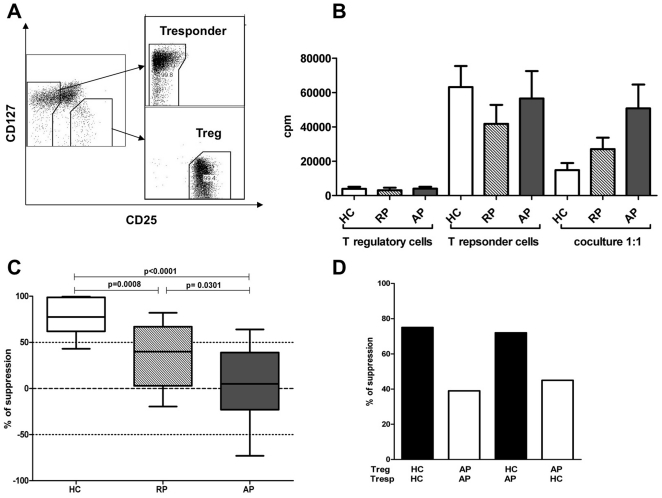
Suppressive function of circulating T regulatory cells.
A, Gating strategy for Treg sorting and typical results after sorting. B, Proliferative responses of Treg, effector responder T cells and Treg:Tresp co-cultures (ratio1/1) upon CD3+CD28 stimulation. Histograms are expressed as mean value +/− SD of cpm for healthy controls (HC ; n = 18), remission patients (RP ; n = 15), and active patients (PA ; n = 19). C, The percentage of suppression of responding cells was determined as 1−(proliferation of co-culture/proliferation of responder population alone)×100. Data are presented as boxplots with whiskers from minimum to maximum. D, A suppressive assay mixing Treg and effector T cells from and AP patient and a healthy volunteer was performed. Black bars represent suppression with HC Treg, and white bars with patient Treg. The results of one experiment out of three with similar results are shown.